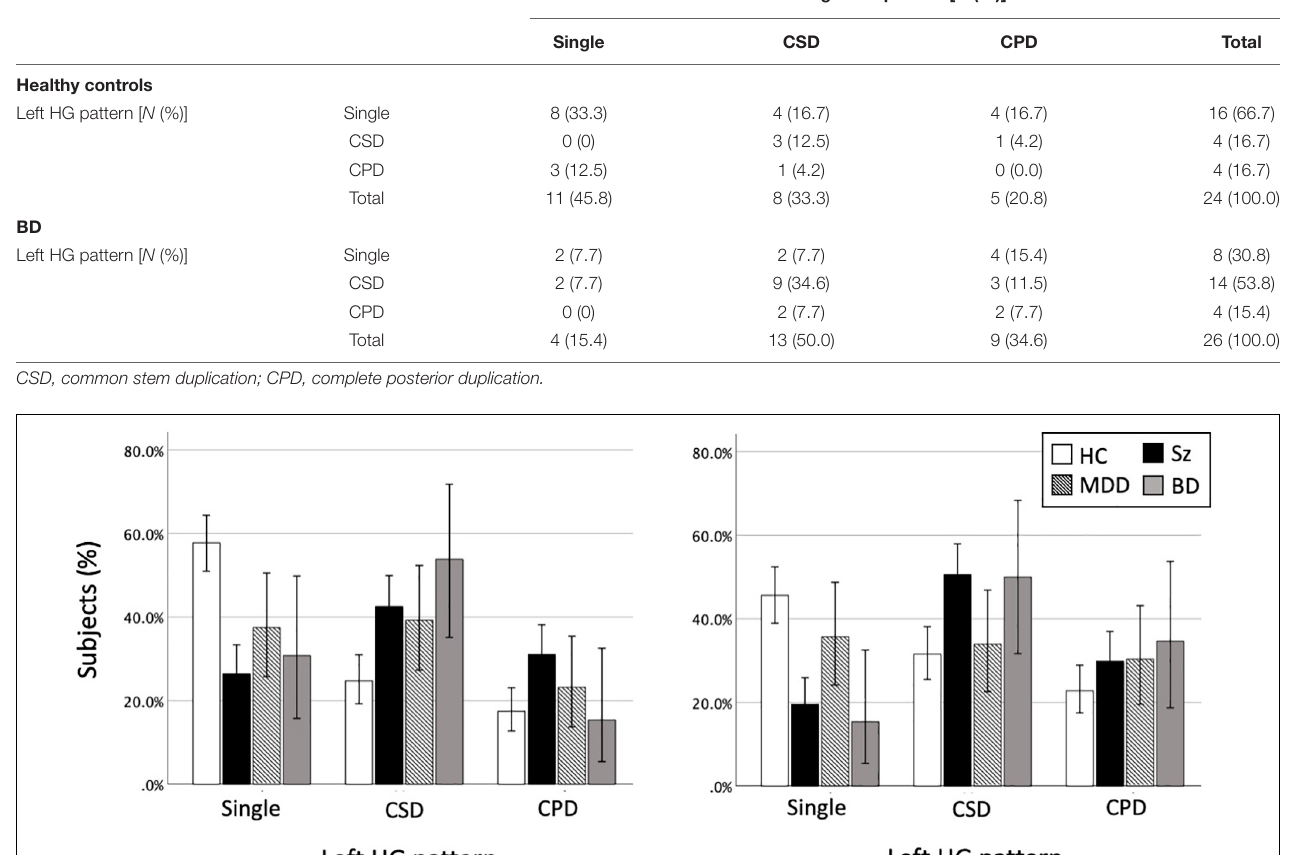
Right HG pattern [ N (%)]